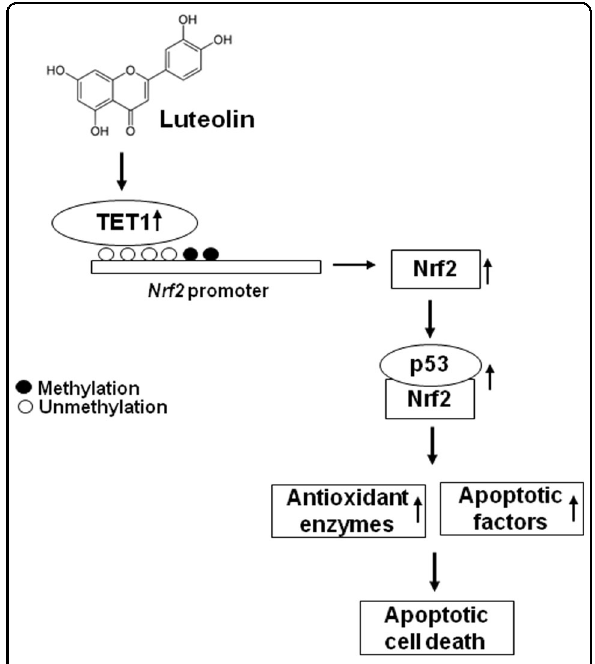
Fig. 7 Proposed model of the roles of TET1 and Nrf2 in the antioxidant and apoptotic effects of luteolin. Luteolin increases the expression of the DNA demethylase TET1, which upregulates the expression of Nrf2 by binding to its promoter in colon cancer cells. Upregulation of Nrf2 expression increases the interaction between p53 and Nrf2, which upregulates the expression of antioxidant enzymes and apoptosis-related proteins. Thus, TET1-mediated upregulation of Nrf2 in luteolin-treated colon cancer cells